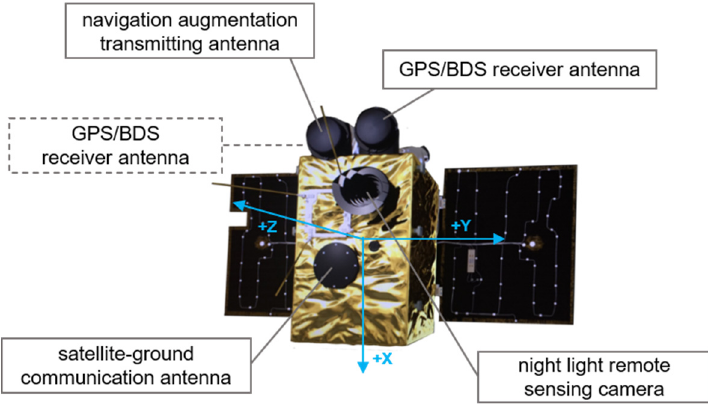
Figure 1. The appearance of the Luojia-1A satellite.